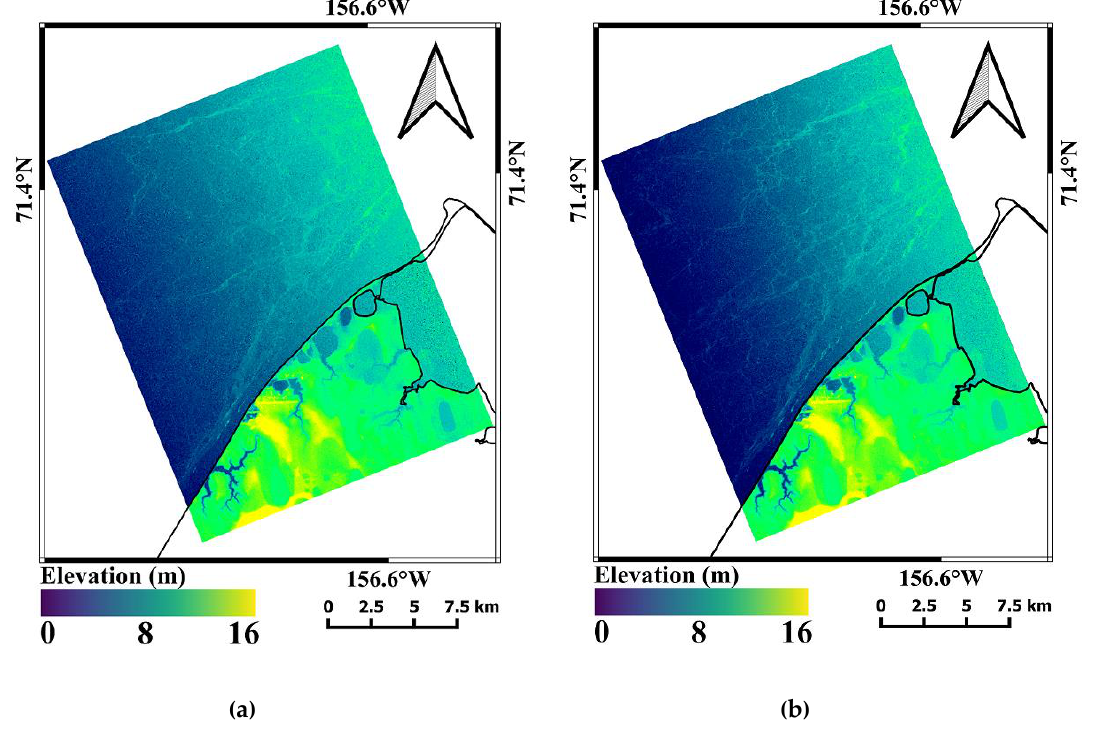
Figure 3. Synthetic aperture radar interferometry (InSAR)-derived elevation for ( a ) 13 Jan and ( b ) 24 Jan, 2012. The coastline is delineated in black.